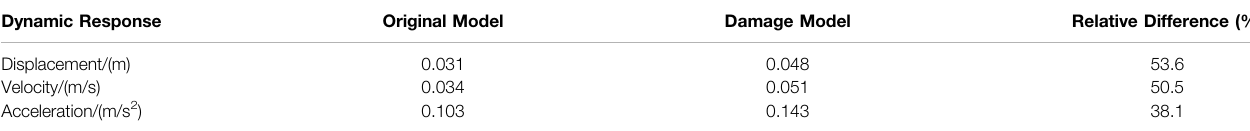
TABLE 9 | Maximum dynamic response original model and damage model of truss. Dynamic